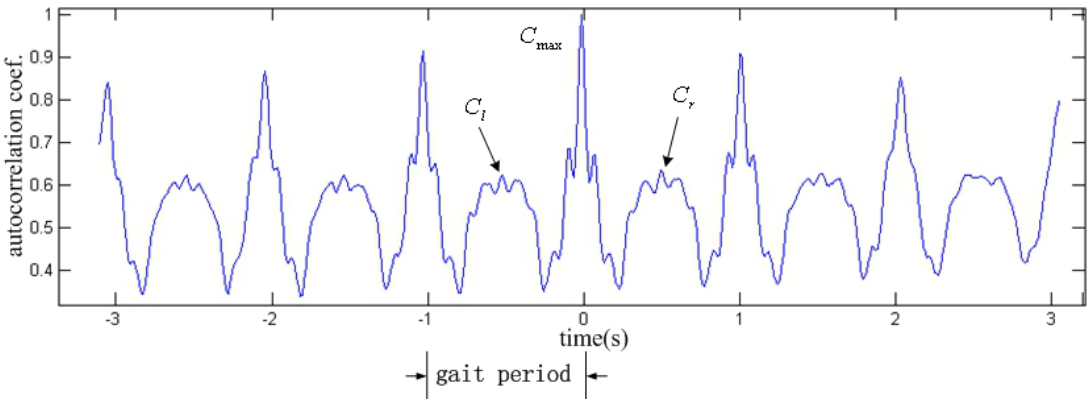
Figure 4. Schematic definition of gait symmetry. The blue line is the autocorrelation curve of